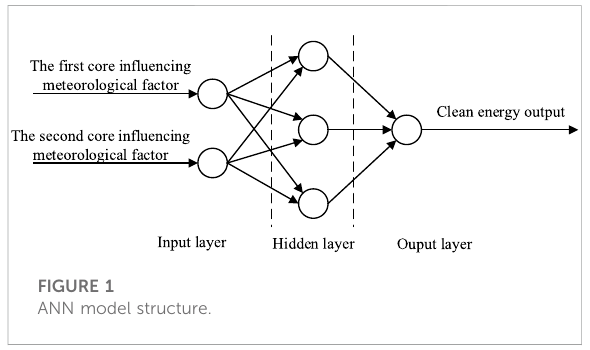
FIGURE 1 ANN model structure.